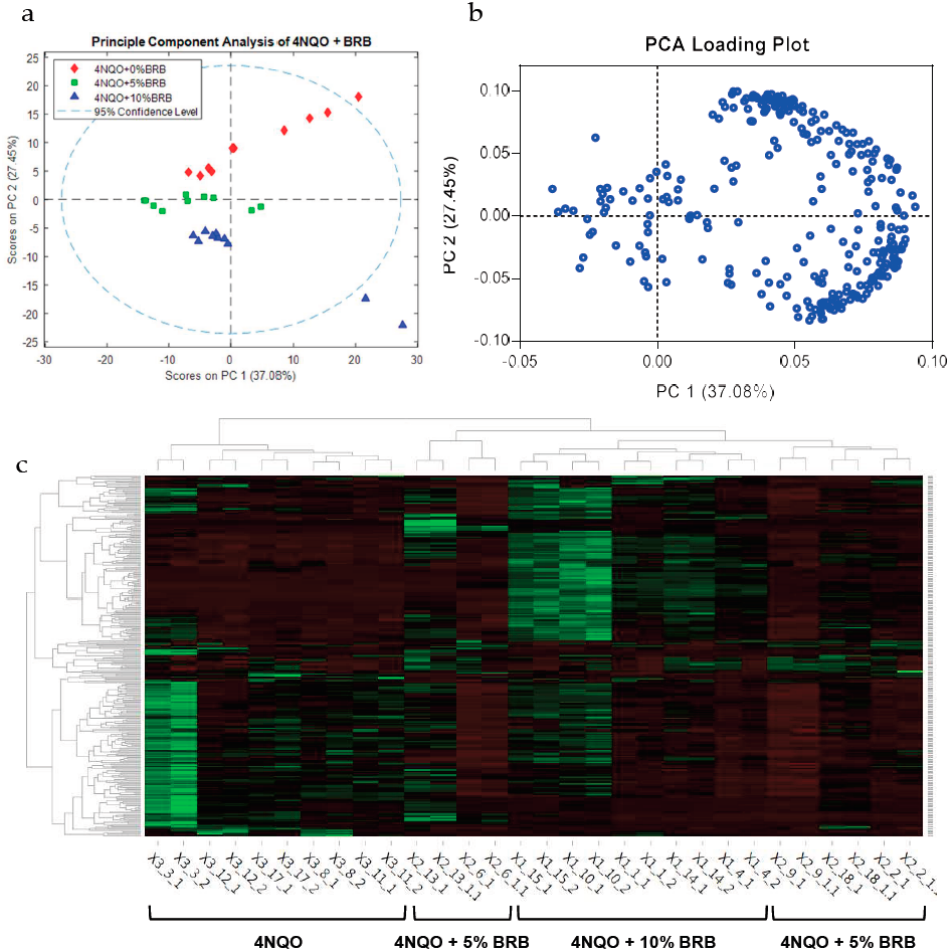
Figure 1. BRBs modulate the metabolic profile of oral cancer induced rats. ( a ) PCA of untargeted metabolomic profiles of urine samples from cancer-induced rats fed the control diet, 5% BRB diet, or 10% BRB diet as determined by LC-MS using the 292 features below the 0.05 p-value cutoff (ANOVA). ( b ) Loading scores for PC1 and PC2 for the top 292 features used in the PCA in ( a ). ( c ) Heat map of differentially expressed metabolites in 4NQO-exposed rats fed the control diet (4NQO), 5% BRB supplemented diet (4NQO + 5% BRB), or 10% BRB supplemented diet (4NQO + 10% BRB).